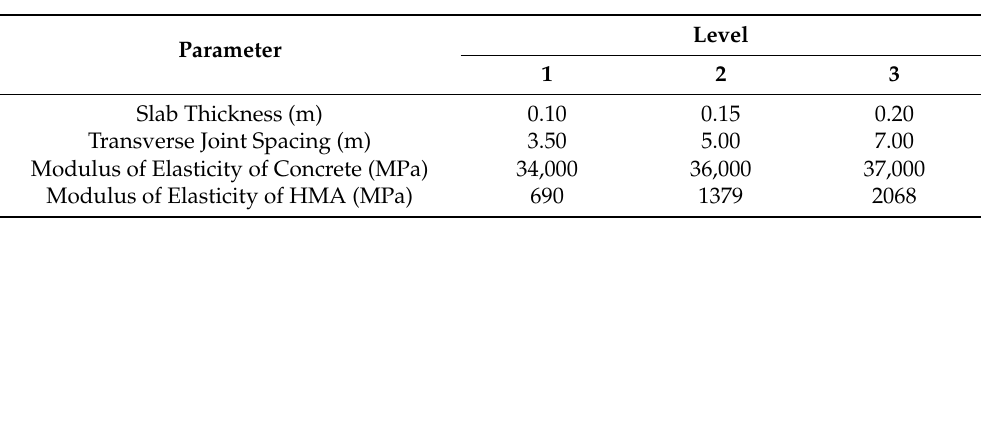
Table 6. L9 orthogonal array.